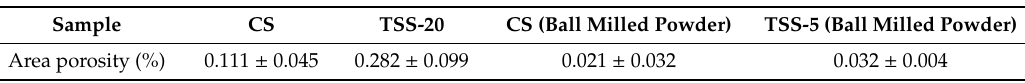
Table 3. Area porosity of conventionally and two-step sintered samples shown in Figures 17 and